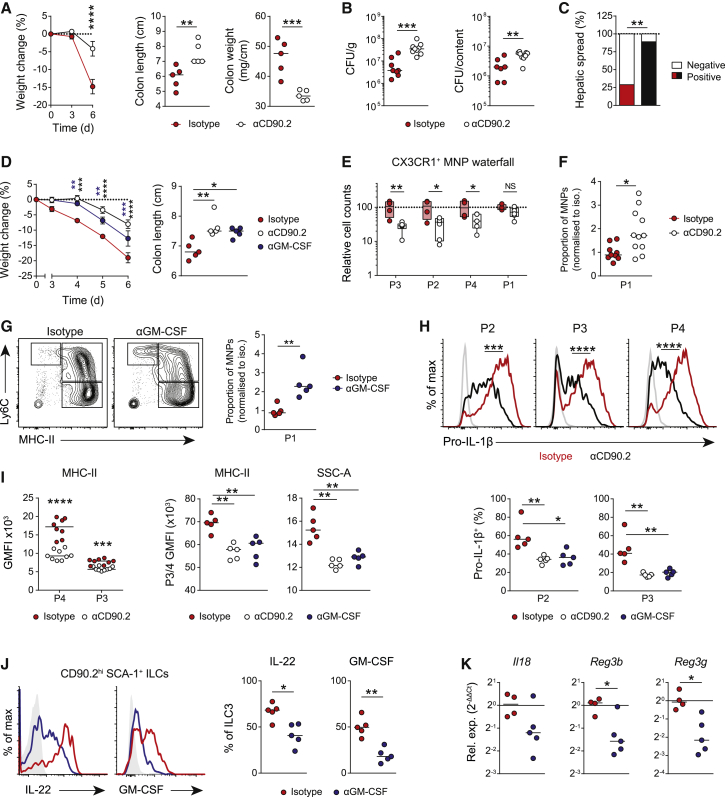
ILCs and Innate GM-CSF Augment Intestinal Macrophage Activation during Enteropathic Infection and Colitis(A) Weight change (left) and colon clinical parameters (right) in Rag2−/− mice treated with 2% DSS ± isotype (n = 5) or anti-CD90.2 IgG (n = 5) antibodies. Mean ± SEM (weight change) and medians (colon parameters) indicated.(B and C) C. rodentium colony-forming units (CFUs) in caecum (B) and liver (C) from isotype (n = 8) or anti-CD90.2 IgG treated (n = 9) Rag2−/− mice at 7 days post-infection (dpi). Medians indicated in (B).(D) Clinical parameters in Rag2−/− mice treated as in (A) or anti-GM-CSF IgG antibodies for 6 days. Mean ± SEM (weight change) and medians (colon parameters) indicated. n = 5 per group.(E) Relative colonic CX3CR1+ MNP counts in mice treated as in (A). Data normalized to isotype. Medians indicated. n = 8–9 per group.(F and G) Proportion of P1 monocytes of total MNPs, normalized to isotype IgG, from mice treated in (A)–(F) or in (D)–(G). Median indicated. n = 5 per group.(H) Pro-IL-1β expression by colonic MNP subsets in mice treated as in (A) (top row, n = 8–9 per group) or in (D) (bottom row, n = 5 per group).(I) MHC-II expression in P3/P4 colonic MNPs in mice treated as in (A) or as in (D). Medians indicated. n = 5–9 per group.(J) IL-22 and GM-CSF production by CD90.2hi SCA-1+ ILCs in Rag2−/− mice treated as in (D). Medians indicated. n = 5 per group.(K) Colon tissue qPCR of IL-22-dependent epithelium genes in mice treated as in (D).n = 4–5 per group. Data are representative of three or more independent experiments, with single experiments (A–E, G, J, and K) or two pooled independent experiments (F, H, and I) shown. p values were calculated using a two-way ANOVA with Sidak’s multiple comparisons test (A) (for weight loss), the nonparametric Mann-Whitney U test (A) (for colon parameters), in (B) and (D) (for colon parameters), and in (F)–(K), Chi-square test (C), two-way ANOVA with Tukey’s multiple comparisons test (D) (weight loss), and multiple t tests with Holm-Sidak correction (E). ∗p < 0.05; ∗∗p < 0.01; ∗∗∗p < 0.001; ∗∗∗∗p < 0.0001. See also Figure S2.